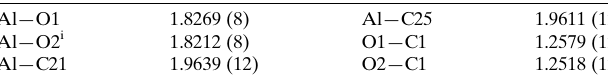
Table 1 Selected bond lengths (A˚ ).